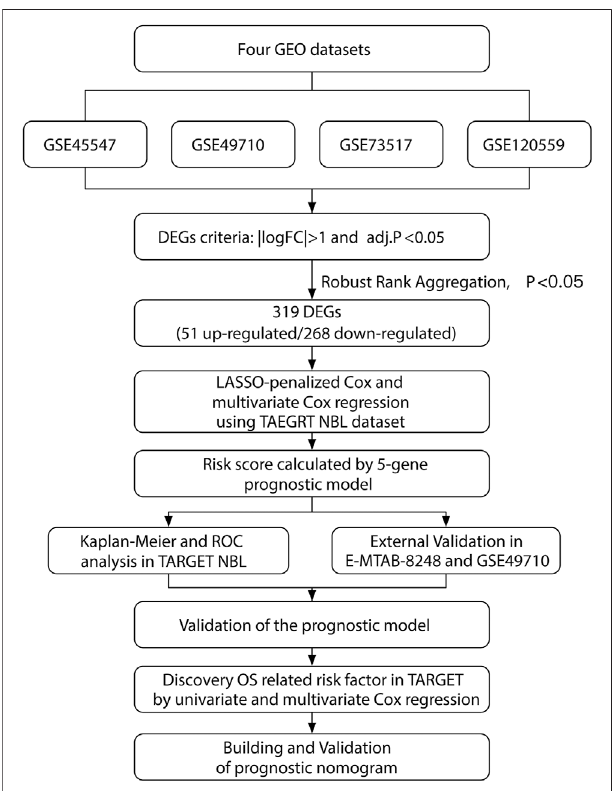
FIGURE 1 | Flowchart illustrating the research